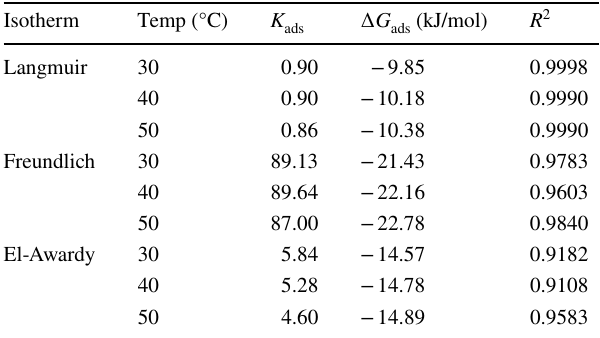
Table 4 Gongronema latifolium adsorption parameters on the mild